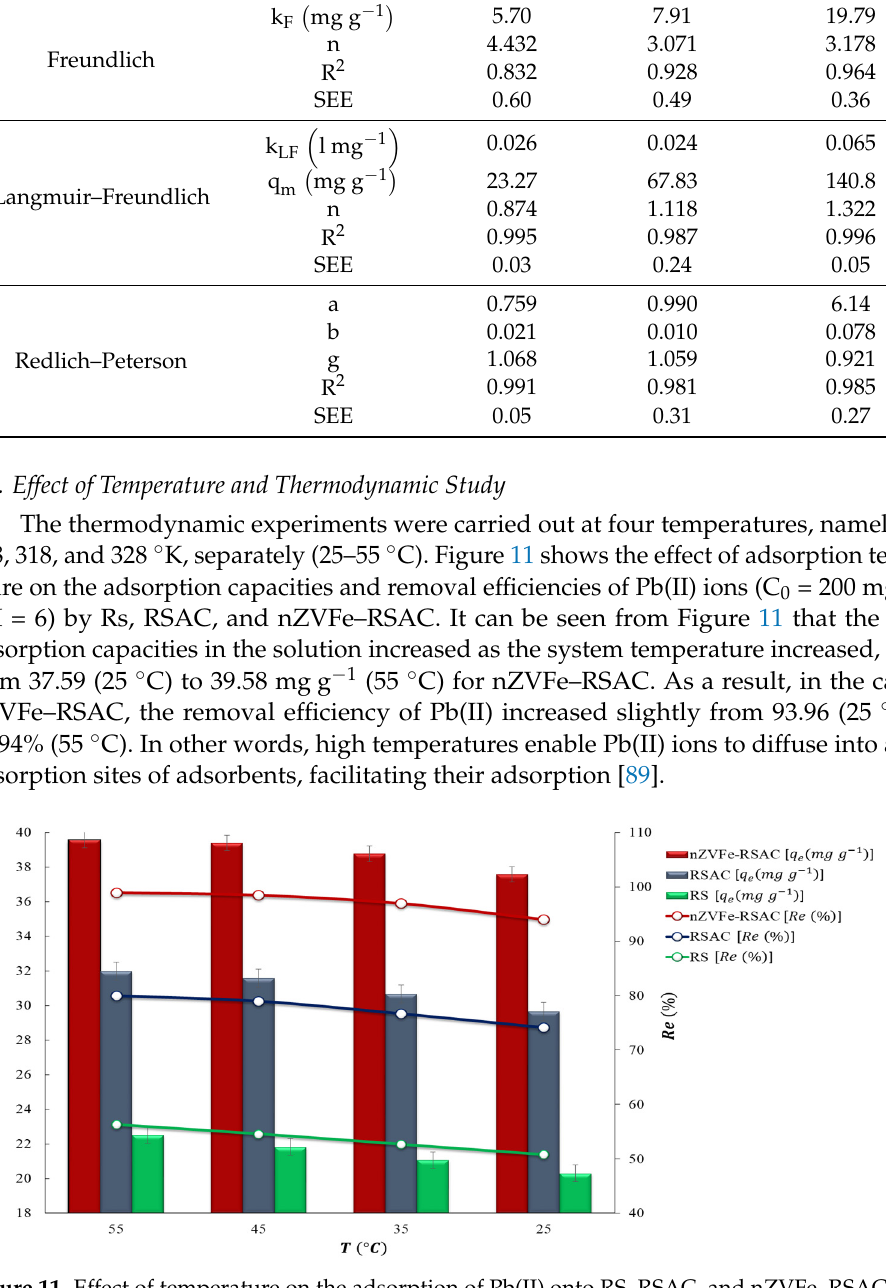
Table 6. Thermodynamics parameters for the adsorption of Pb(II) on nZVFe–RSAC nanocomposite . Thermodynamic Parameters